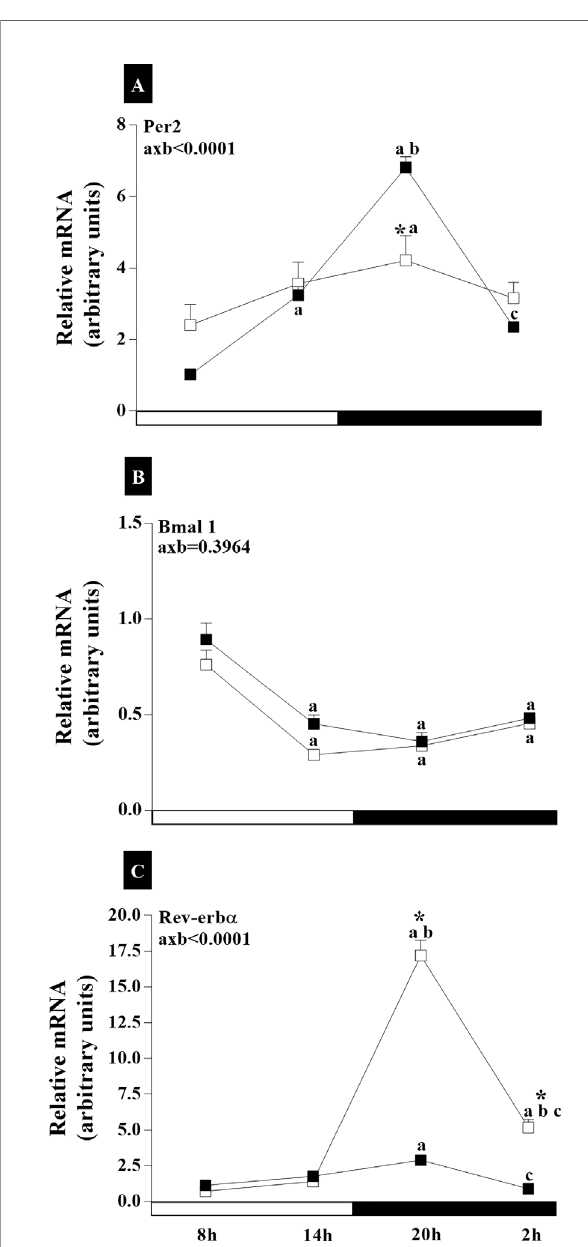
FIGURE 8 | Daily oscillations in relative mRNA expression for Per2 , Bmal1 , and Rev-erb a in the ovary. Light and dark phases are represented along the X-axis by their respective schedules. Beginning of the light phase at 07:00, when the lights are turned on. The dark phase started at 19:00. All samples were collected at six-hour intervals after the fi rst hour (i.e., 08:00) for 24 h. Light/dark cycle = 12/12 h. (A) Relative temporal expression of mRNA for Per2 , (B) Bmal1 , and (C) Rev-erb a in animals with a regular cycle on diestrus day and irregular cycle in persistent diestrus. * indicates intergroup variation at the same time: ( ■ ) Regular estrous cycle on diestrus day × ( □ ) Irregular cycle in persistent diestrus. Letters indicate temporal variation within the group. a vs. 08:00; b vs. 14:00; c vs. 20:00. axb = age and time of day interaction. n = 3 – 7. Replicates with a variation above 0.2 were automatically excluded from the groups. DD Ct for Per2 and Rev-erb a ; relative standard curve for Bmal1